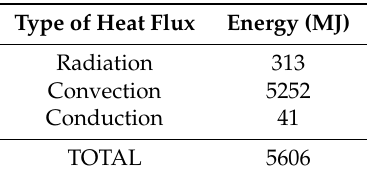
Table 2. Amount of energy lost for an opening of 600 s for radiation, convection and conduction.